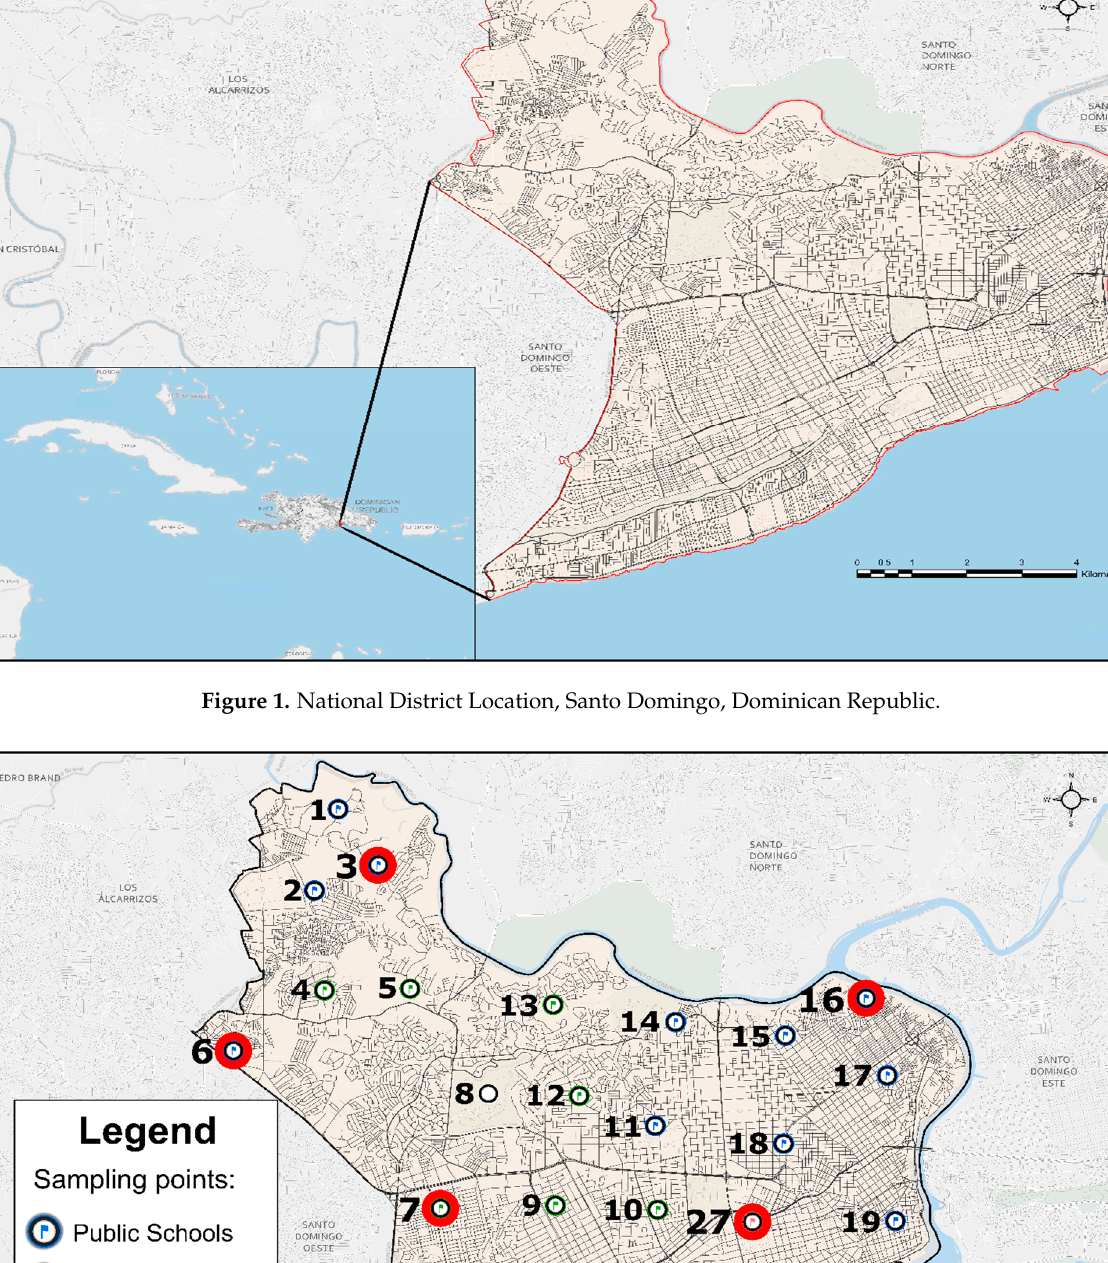
Table 1. Description of selected categories for geospatial analysis of vegetation cover by iTree can- opy. Source: Own elaboration.